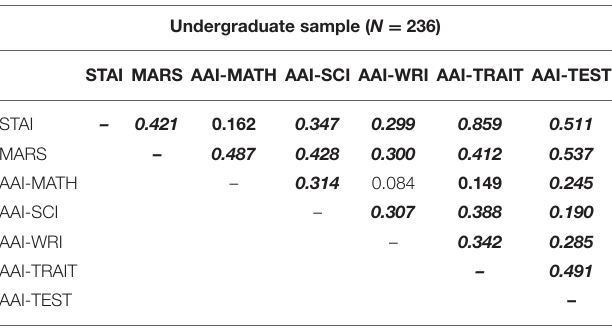
TABLE 6 | Pearson correlations between domain subscales of the AAI and established measures of math and trait anxiety in Study 2. Undergraduate sample ( N =